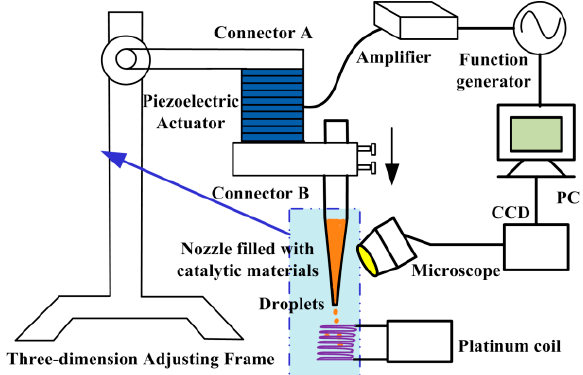
Figure 3. Schematic of the droplet generating device for coating catalytic materials.